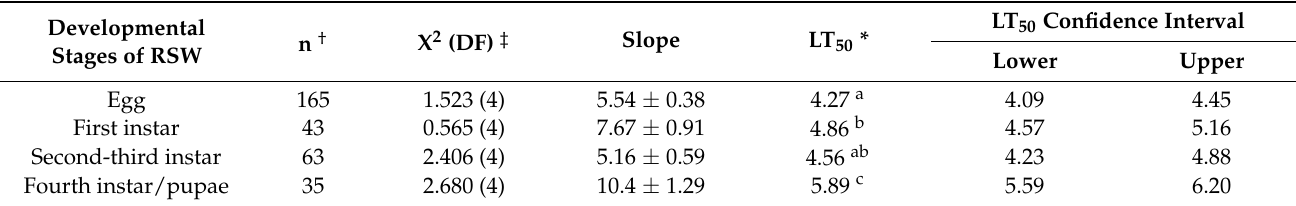
Table 2. Time—dose toxicity of S. lanosoniveum against different developmental stages of A. rugioperculatus at the concentra- tion of 1 × 10 8 conidia per mL.